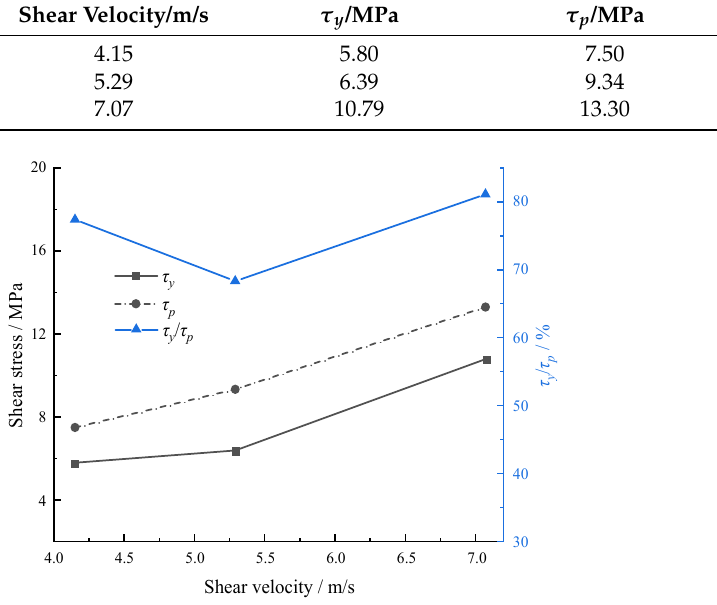
Figure 15. Yield stresses under high velocity impact (Note: τ p data are from Wang et al. [79]).